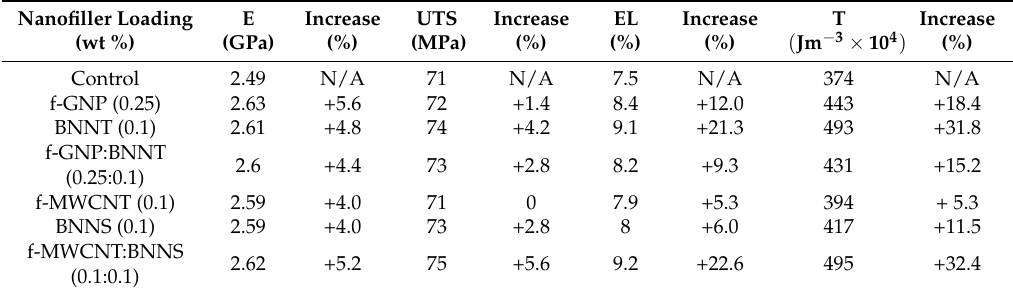
Figure 6. ( a ) Young’s modulus; ( b ) ultimate tensile strength (UTS); ( c ) elongation at break (%), and ( d ) toughness from stress-strain curve of neat epoxy, and epoxy with single component and the hybrid nanofiller systems. The filler content for each sample was: 0.25 wt % f-GNP; 0.1 wt % BNNT; 0.1 wt % f-MWCNT; 0.1 wt % BNNS. In all cases, error bars indicate standard deviation. Table 4. Variation of E, UTS, %EL and T for epoxy with single component and the hybrid nanofiller systems relative to the control neat epoxy.